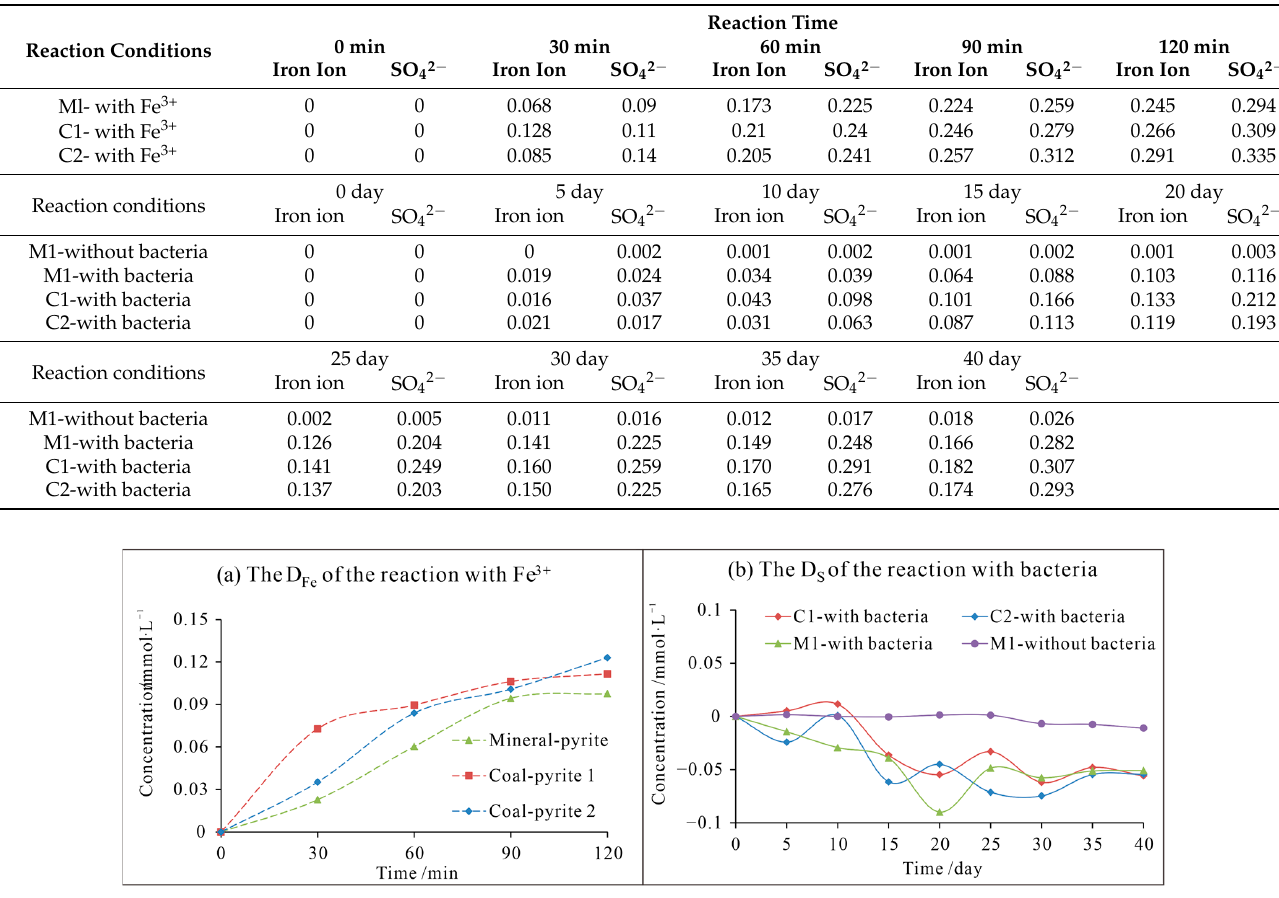
Figure 13. The calculation results of the concentration difference parameters in the two reaction systems: ( a ) is the concentration difference parameter of iron ion (D Fe ); ( b ) is the concentration difference parameter of SO 42 − (D S ).